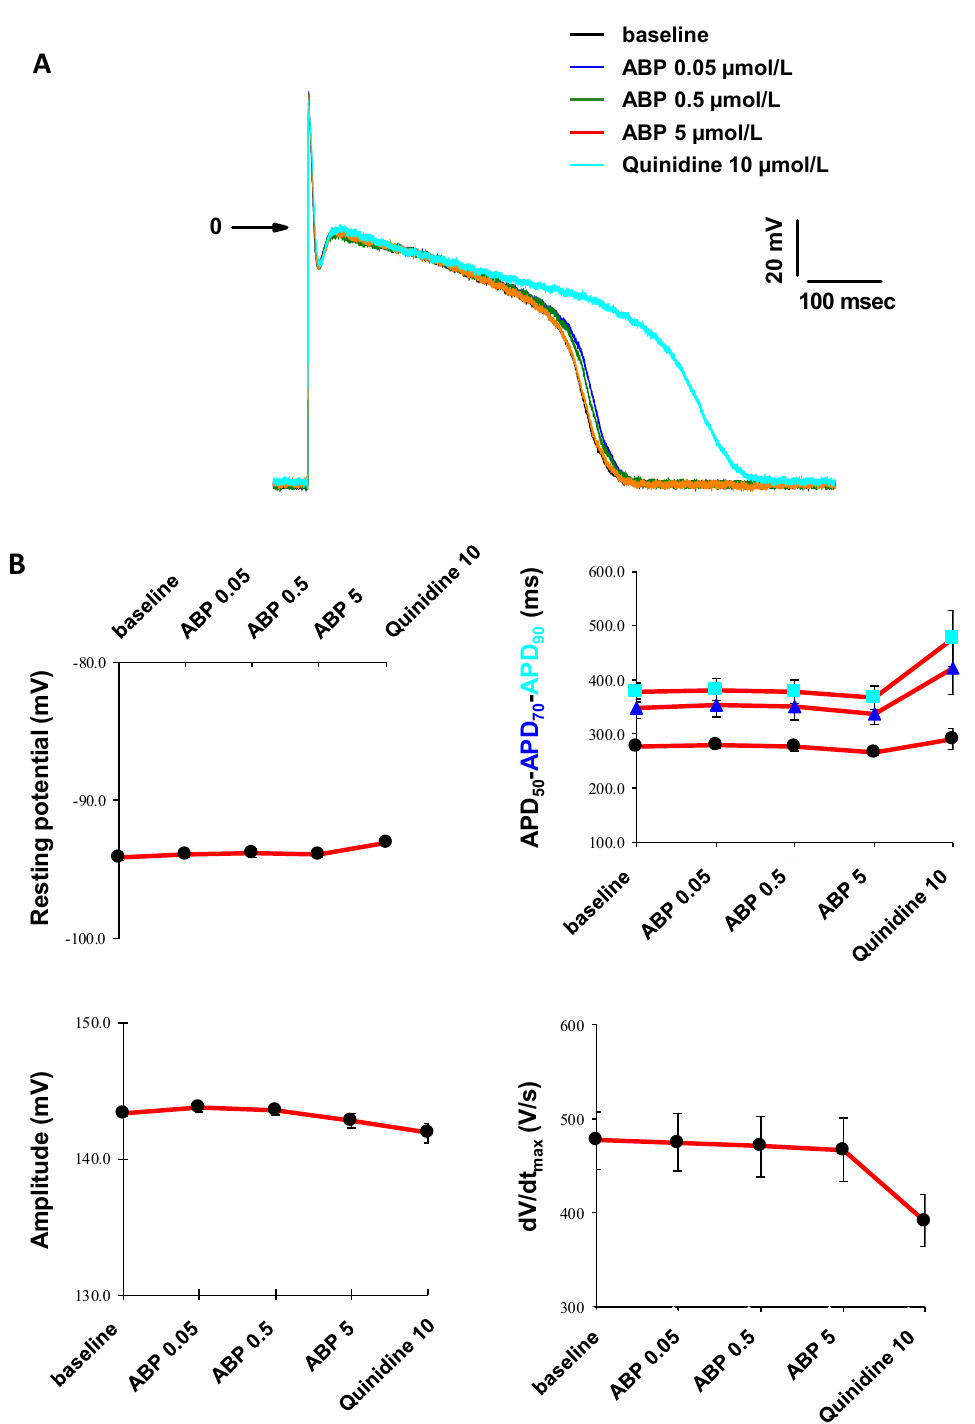
Figure 7. ( A ) Time-dependent effects of the ABP dendrimer at different concentrations and of Quinidine at 10 µM on the action potential at 1 Hz (one Purkinje fiber representative of three). ( B ) Effects of the ABP dendrimer at different concentrations and of Quinidine at 10 µM on the four action potential parameters at 1 Hz (Data are expressed as mean ± SEM, n = 3 Purkinje fibers).